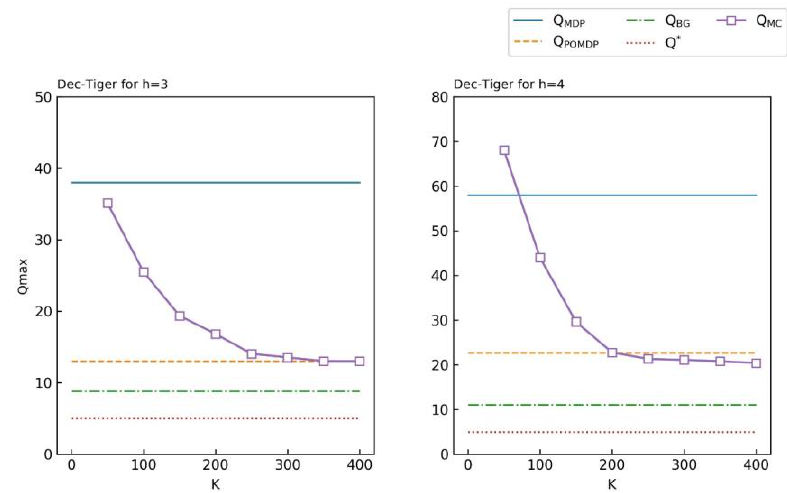
Figure 4. Convergence of MC Q . as the sample time K increases. MC Q converges to POMDP Q , which means Q is an upper bound for Q * , but is less compact than MC